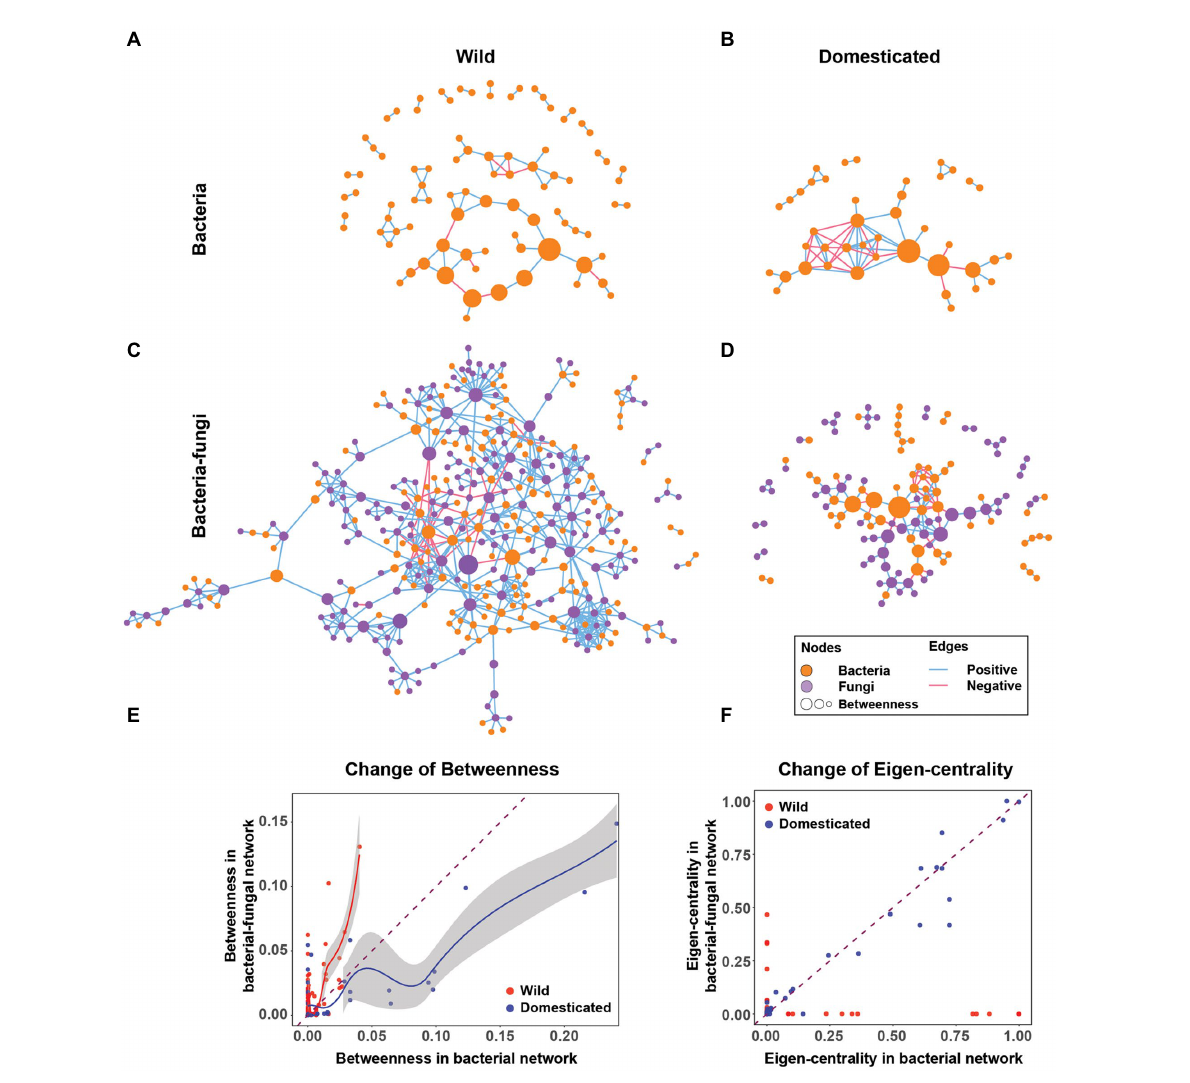
FIGURE 1 Cross-kingdom networks and bacteria-only networks in wild and domesticated rice seed microbiomes. (A,B) Bacteria-only co-occurrence network of wild and domesticated rice seed microbiomes. (C,D) Cross-kingdom (bacterial-fungal) co-occurrence network of wild and domesticated rice-seed microbiomes. Orange nodes are bacterial nodes. Purple nodes are fungal nodes. The size of the node is proportionate to betweenness centrality. Blue edges are co-occurrence network edges with positive correlation coefficients. Red edges are co-occurrence network edges with negative correlation coefficients. (E) Change of betweenness centrality of the same bacterial nodes in the bacteria-only network ( x -axis) and bacterial-fungal network ( y -axis). (F) Change in eigenvector centrality of the same bacterial nodes from a bacteria-only network ( x -axis) to a bacterial-fungal network ( y -axis). The dashed line is y = x . Solid lines (red and blue) are regression curves using locally weighted smoothing (loess) to wild and domesticated nodes, respectively. The grey area next to the regression curves indicates a 95%